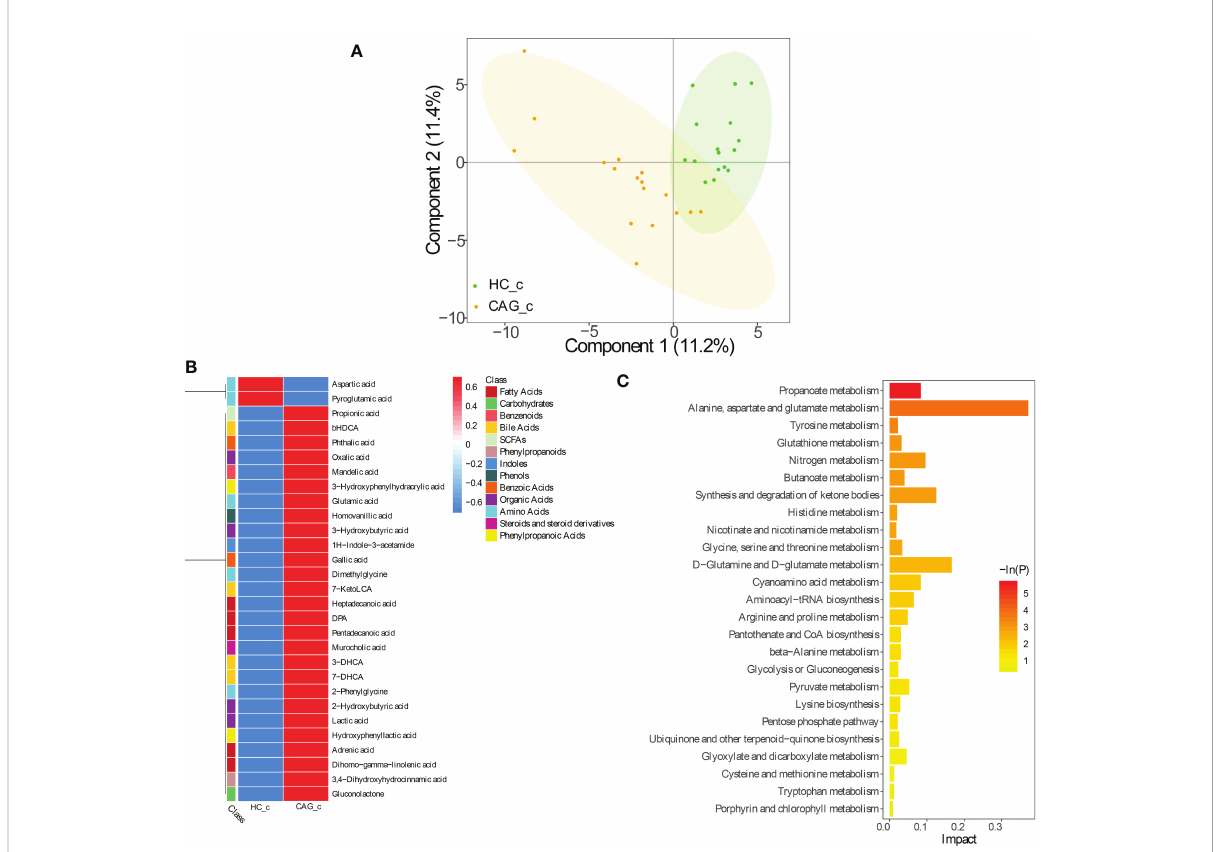
FIGURE 3 Alteration of fecal-derived metabolites pro fi les in CAG_c patients. (A) PLS-DA indicated the difference of fecal metabolites between CAG_c and HC_c healthy volunteers. (B) Alteration of fecal-derived metabolites pro fi les in CAG_c patients. (C) . All differential metabolites enriched for metabolic pathways based on KEGG analysis. Values were expressed as mean ± SD (n=16/HC_c, n = 17/CAG_c). Data were analyzed by t-test or Wilcoxon test based on whether the data were normally distributed between CAG_c group and HC_c